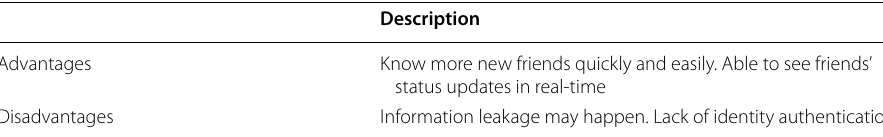
Table 4 Advantages and disadvantages of social media